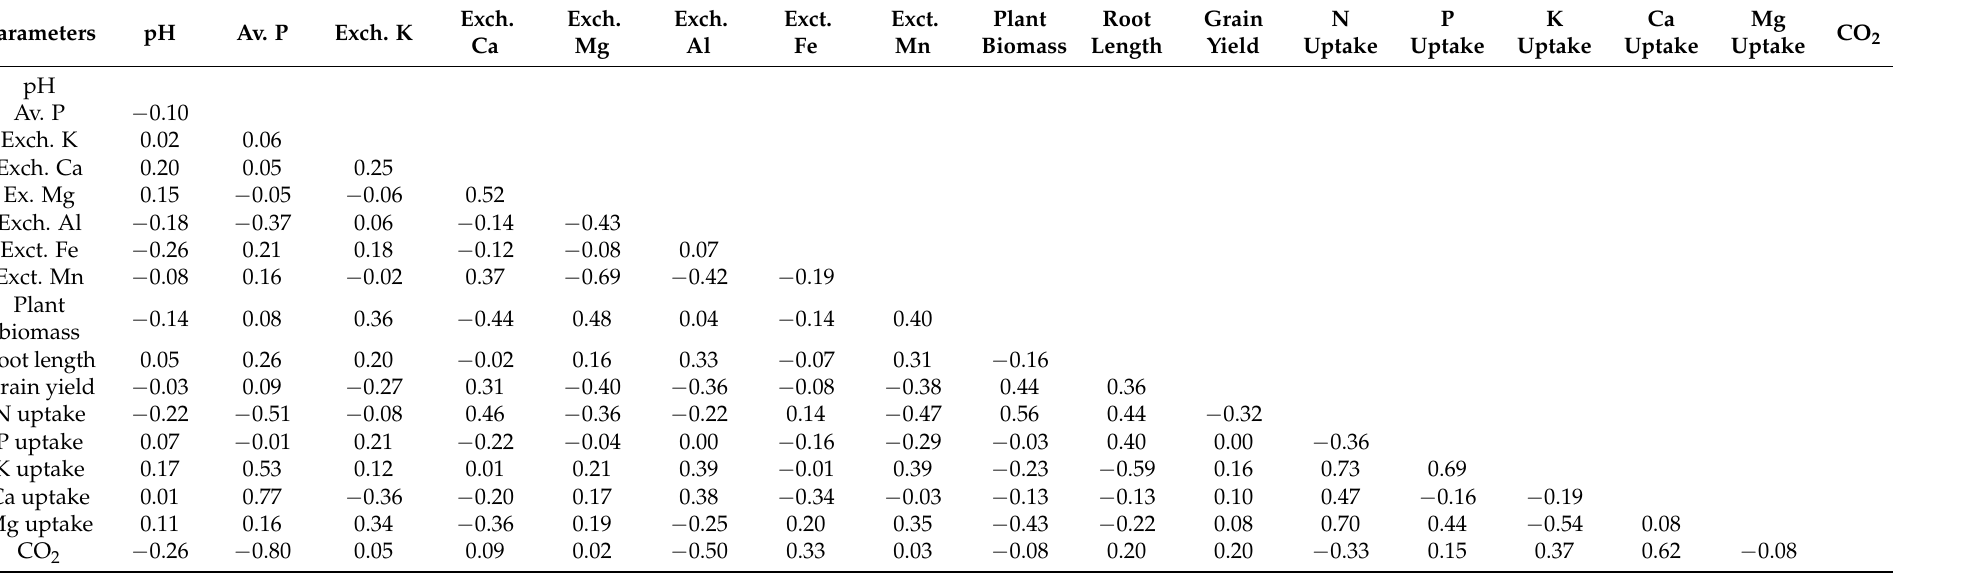
Table 6. The correlation coefficients among maize plant parameters, nutrient uptake, soil pH, and nutrients (all relations were